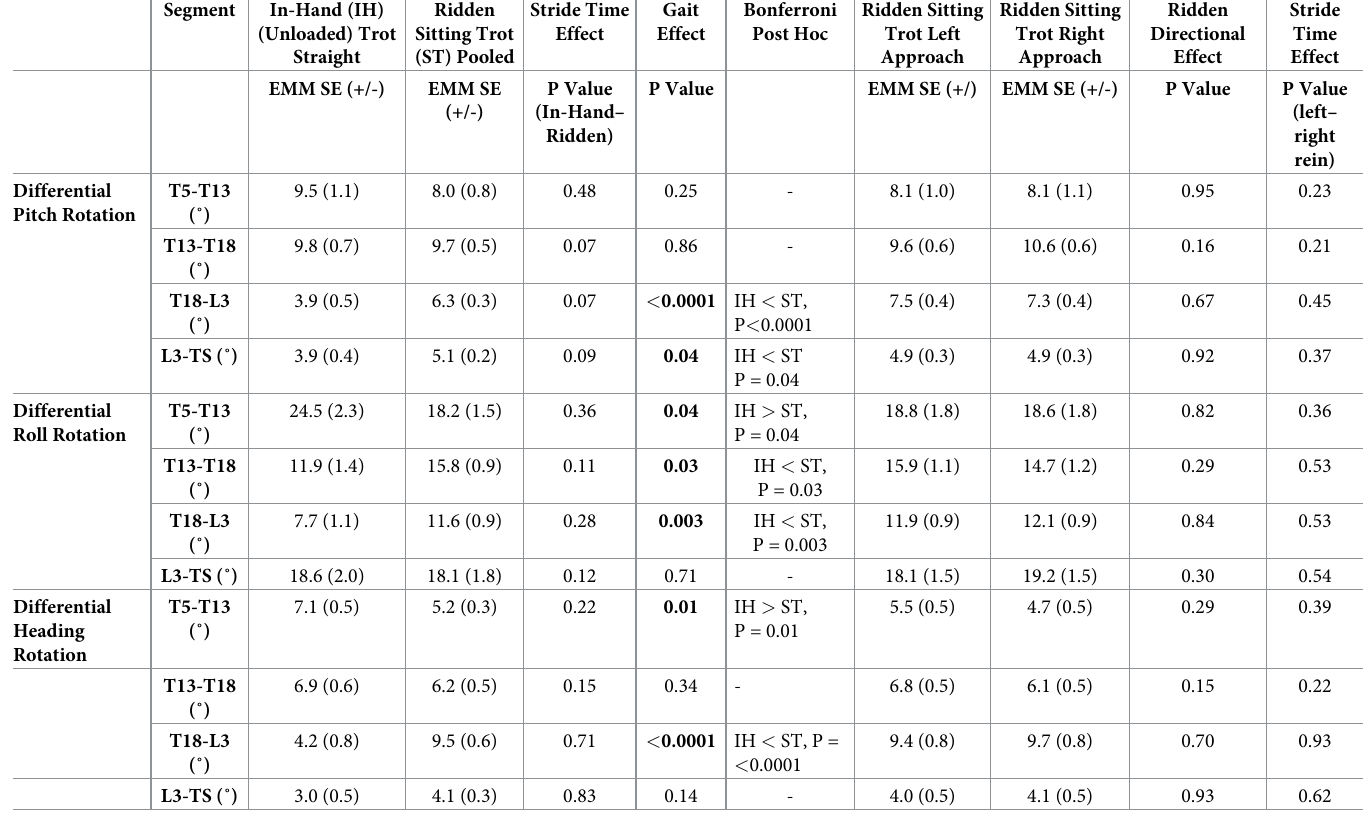
Table 1. Displaying estimated marginal mean (EMM) +/- standard error (SE) for differential pitch, roll and heading rotational values (in degrees) for the thoraco- lumbosacral spine in the unloaded condition in-hand trot and sitting trot from 33 straight trots.